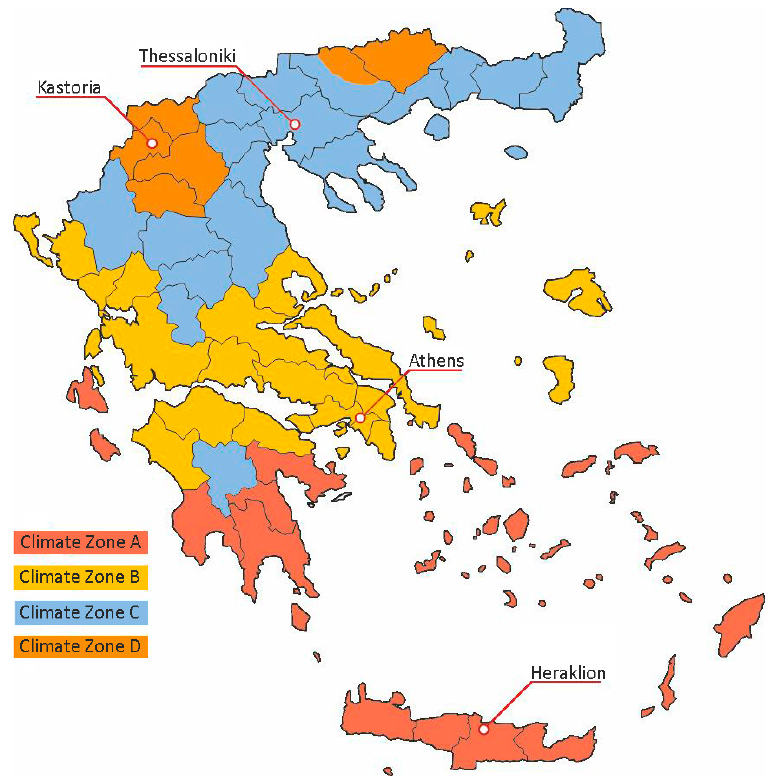
Figure 1. The four climate zones of Greece according to the KENAK regulation.